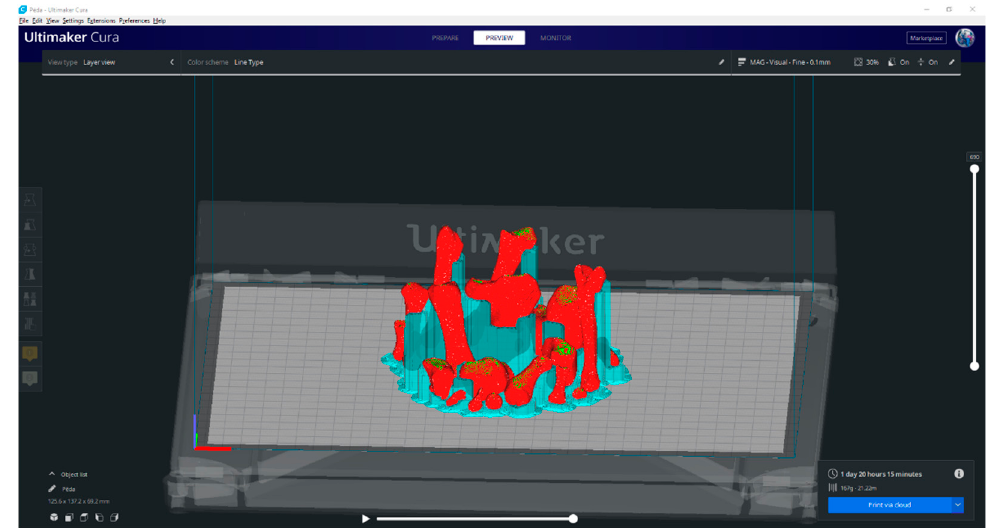
Figure 4. The graphical user interface of the “ Ultimaker Cura ” program. Individually positioned bones of the foot 3D model are shown in red color, supporting structures are shown in turquoise color.